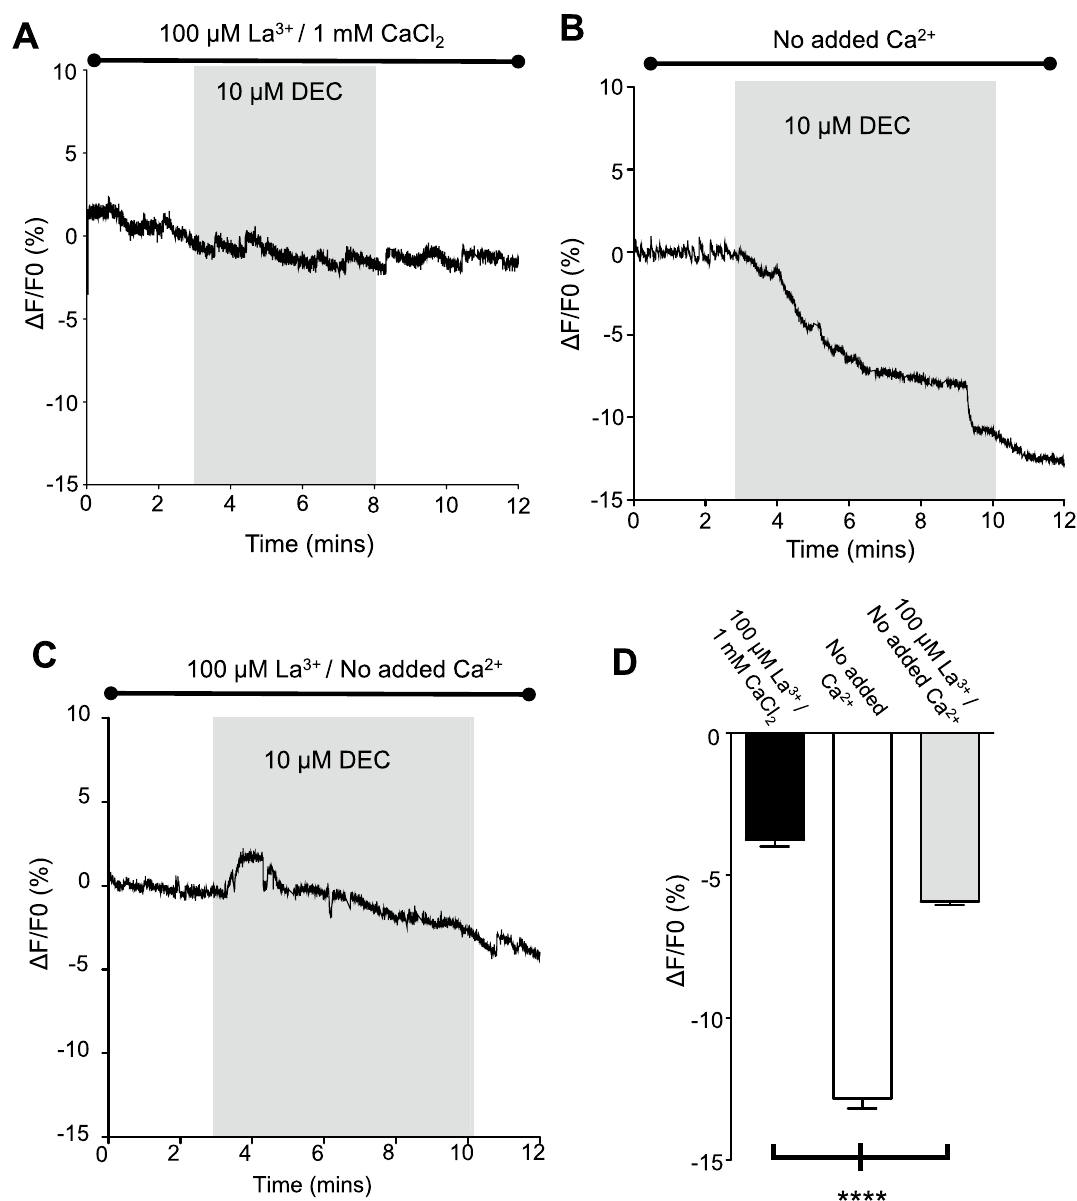
Figure 5. DEC Ca 2+ signal changes are inhibited by La 3+ : ( A ) Representative trace of the inhibition of the effect of application of 10 µM DEC (grey box) by 100 µM La 3+ in 1 mM extracellular Ca 2+ APF. ( B ) Representative trace of the reduction of the Ca 2+ signal produced by 10 µM DEC in no added Ca 2+ APF. Grey box indicates 10 µM DEC application. ( C ) Representative trace of the inhibition by 100 µM La 3+ of the reduction of the Ca 2+ signal produced by 10 µM DEC in the no added Ca 2+ APF. Grey box indicates 10 µM DEC application. ( D ) Histogram of the mean ± SEM reductions in Fluo-3 fluorescence in samples bathed in 100 µM LaCl 3 and 1 mM CaCl 2 bath solution (black bar), ( n = 5 intestinal preparations from 5 individual female worms), samples bathed in no added CaCl 2 APF (white bar) ( n = 8 intestinal preparations from 6 individual female Ascaris), and samples bathed in 100 µM LaCl 3 and no added Ca 2+ bath solution (grey bar) ( n = 10 intestinal preparations from 6 individual female worms) ***Significantly different to 100 µM LaCl 3 and 1 mM CaCl 2 bath solution (100 µM LaCl 3 and 1 mM CaCl 2 bath solution vs no added CaCl 2 APF P = < 0.0001, t = 18.90, df = 748, unpaired t -test; 100 µM LaCl 3 and 1 mM CaCl 2 bath solution vs 100 µM LaCl 3 and no added Ca 2+ bath solution P = < 0.0001, t = 8.862, df = 748, unpaired t -test). All values represented as means ±